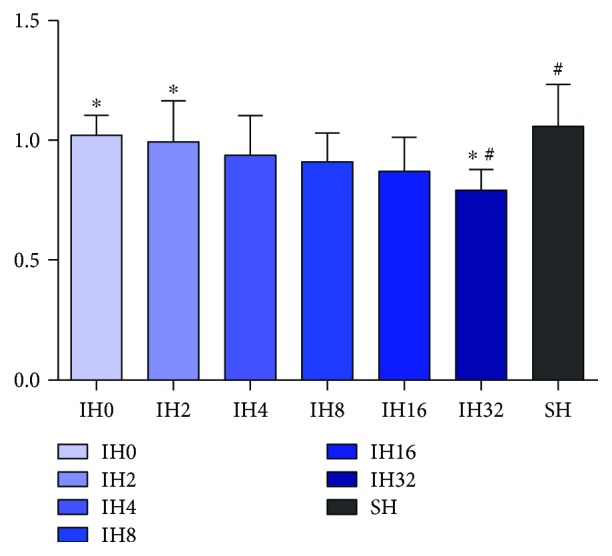
Effect of different numbers of IH cycles on IRS-1 mRNA expression (n = 9) (IH32 vs IH0 or IH2 ∗P < 0.05, IH32 vs SH #P < 0.05).